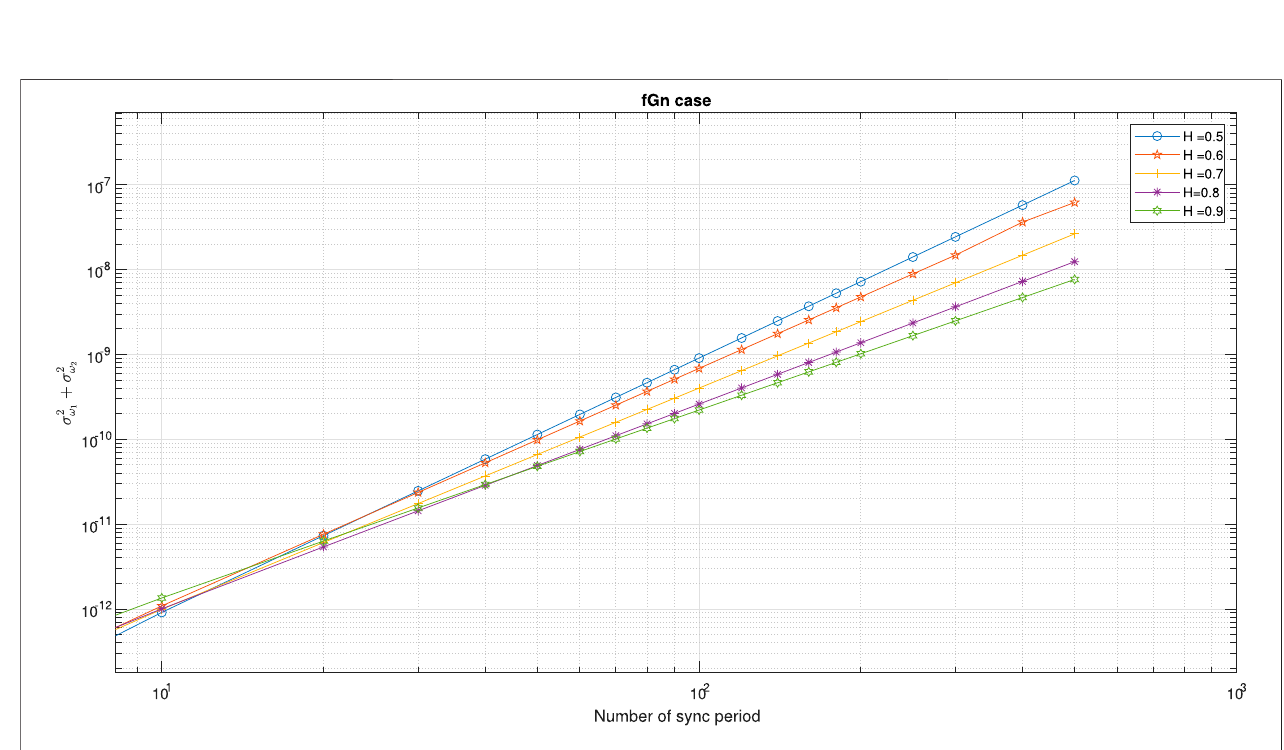
) and E [ e 2 ] (cid:1) 10 – 12 . sec